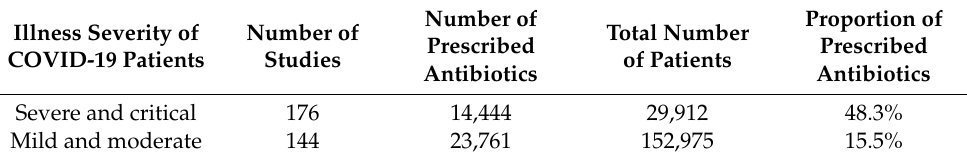
Table 2. Severity of illness and antibiotic prescribing in COVID-19 patients.